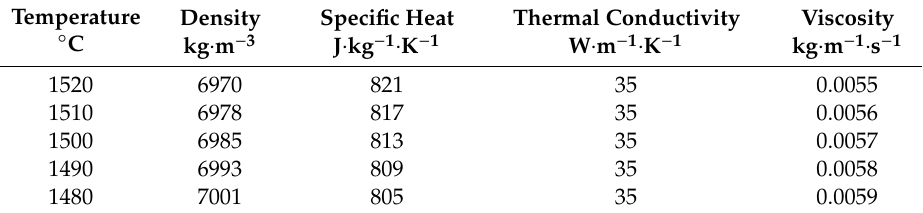
Table 2. Thermo-physical properties of steel defined as a function of temperature.